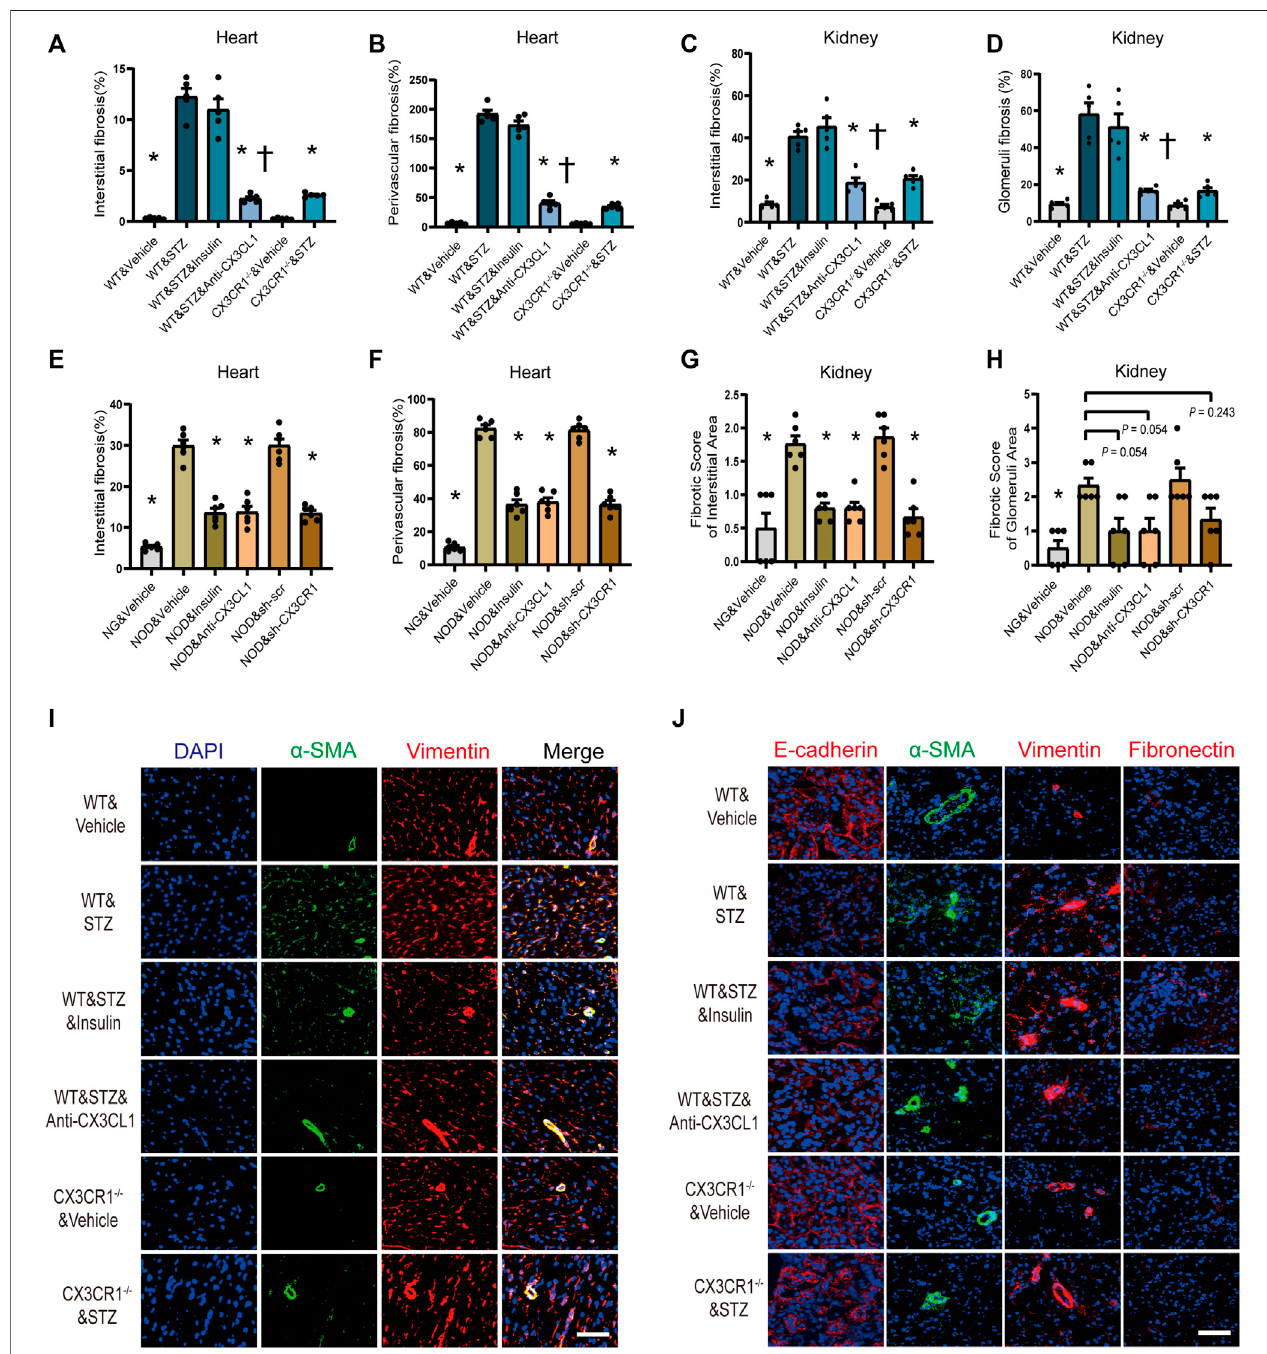
FIGURE6| InhibitionofCX3CL1/CX3CR1attenuated fi brosisindiabetesmice. (A) Myocardialinterstitial fi brosisinSTZ-inducedDMmice. (B) Perivascular fi brosis ofheartinSTZ-inducedDMmice. (C) FibroticscoreoftherenalinterstitialareainSTZ-inducedDMmice. (D) FibroticscoreoftheglomeruliareainSTZ-inducedDMmice. (E) Myocardialinterstitial fi brosisinNODmice. (F) Perivascular fi brosisofheartinNODmice. (G) FibroticscoreoftherenalinterstitialareainNODmice. (H) Fibroticscore of the glomeruli area in NOD mice. (I) Representative images of immunostaining for DAPI (blue), α -SMA (green) and vimentin (red) in heart tissue. Scale bar = 100 μ m. (J) Representative images of immunostaining for E-cadherin (red), fi bronectin (red), vimentin (red), and α -SMA (green) in kidney tissue. Scale bar = 100 μ m. For panels (A – D) , * p < 0.05 vs . WT&STZ group; † p < 0.05 vs . WT&STZ&Insulin mice; n = 5 per group. For panels (E – H) , * p < 0.05 vs . NOD&Vehicle group; n = 6 per group. Experiments presented in panels (A – H) were analyzed using one-way ANOVA followed by Bonferroni ’ s post hoc test.